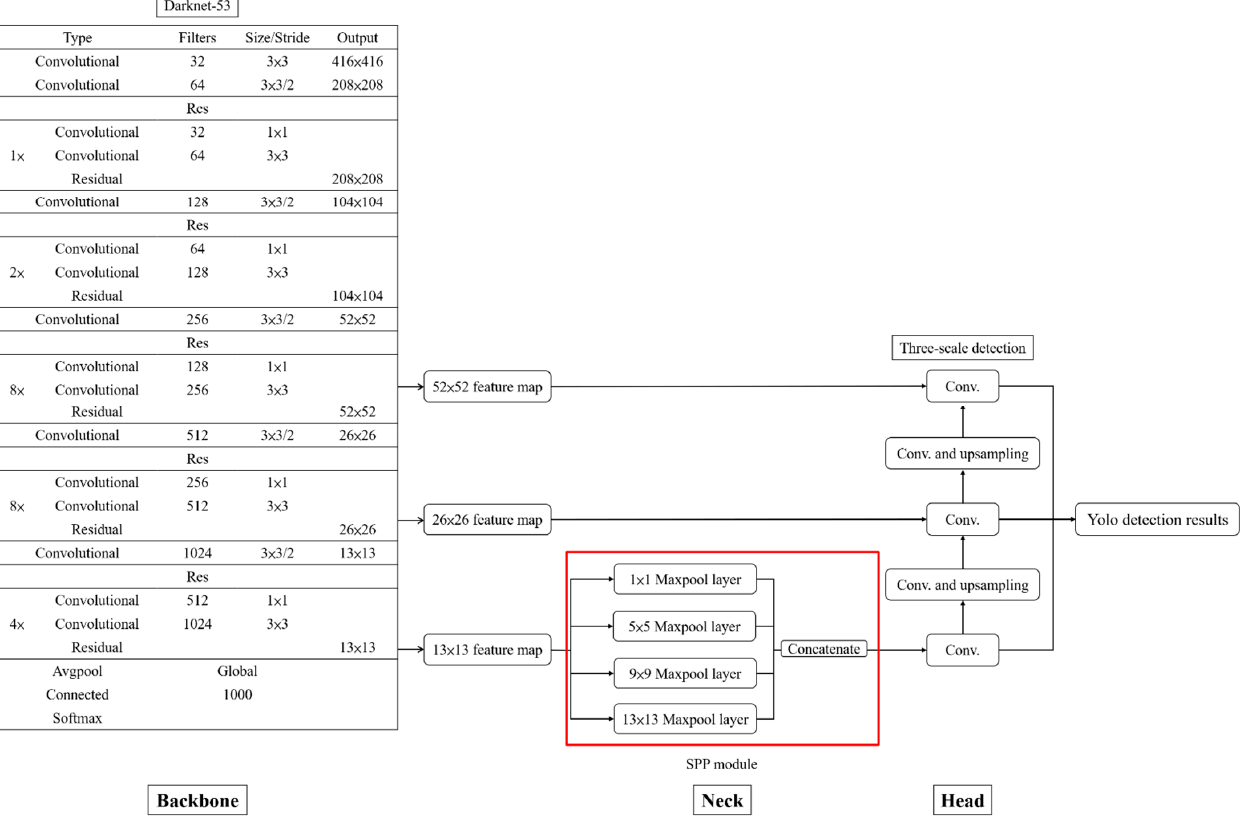
Figure 1. Proposed modified Yolov3 network with SPP module.